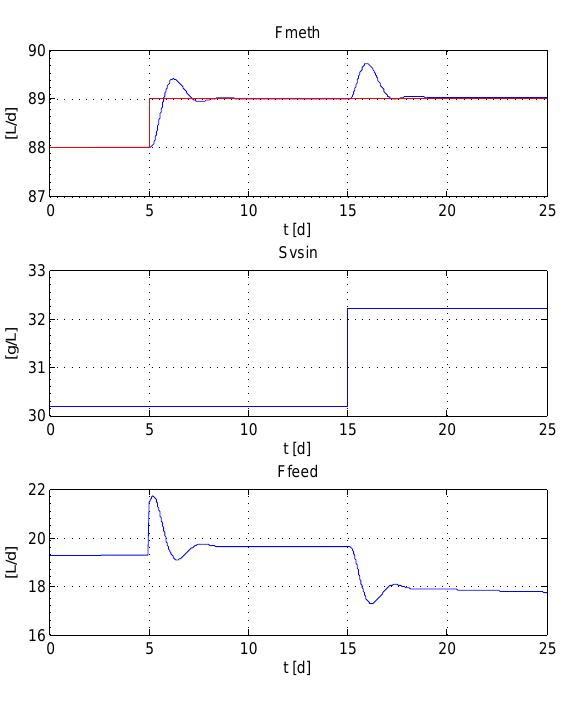
Figure 10: Simulation of control system with optimal PI